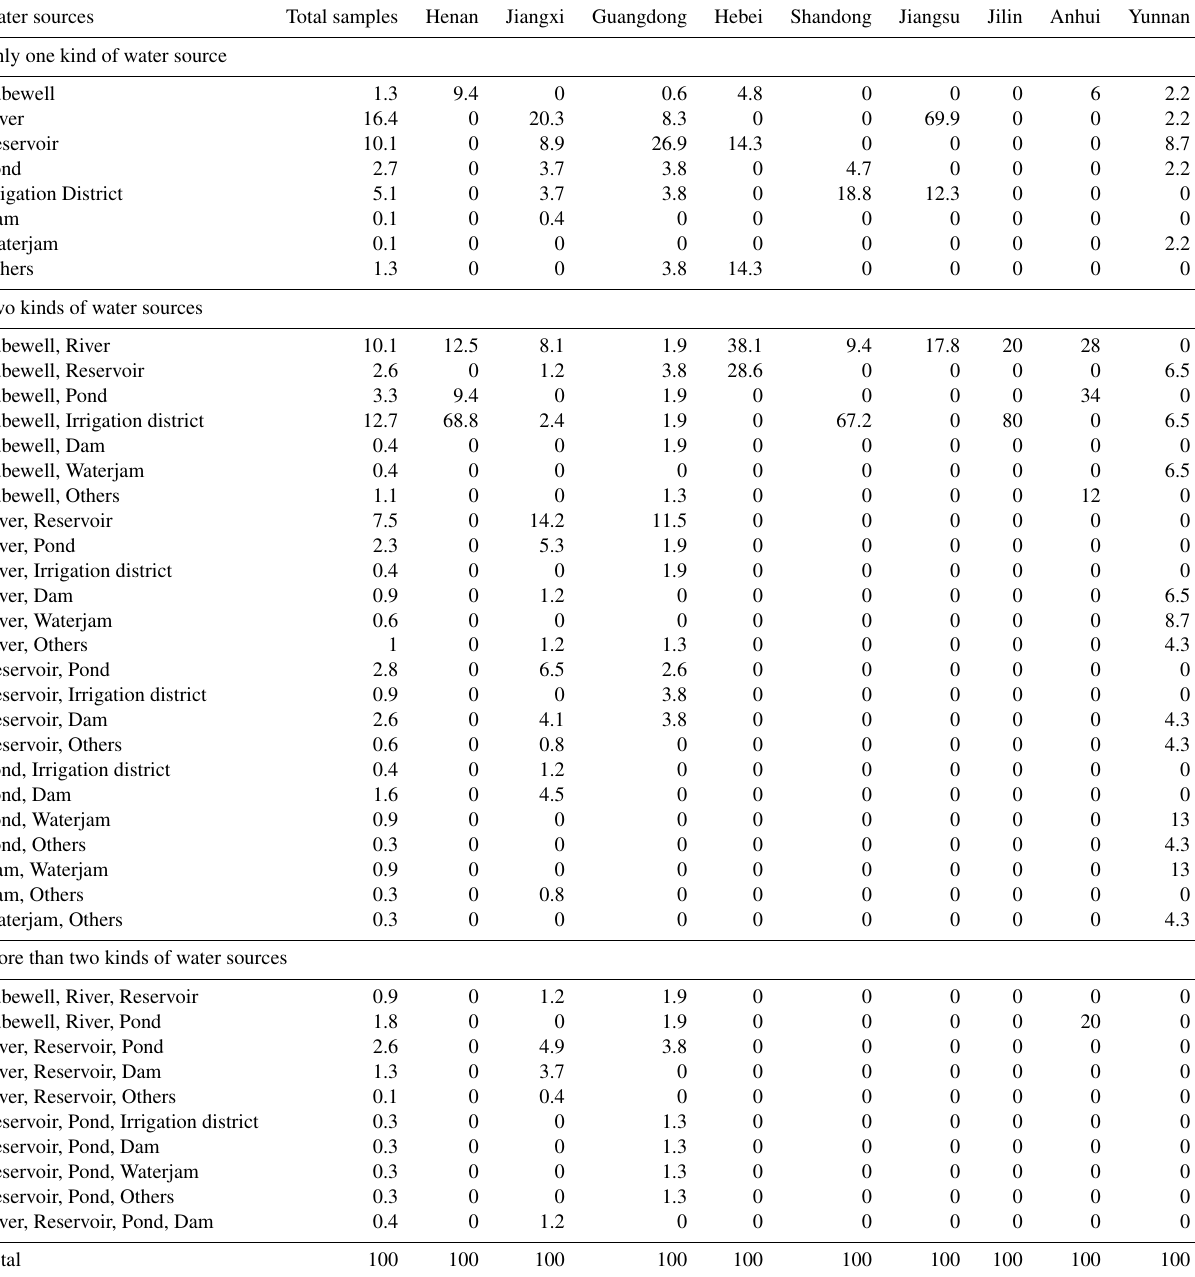
Table A4. Percentage of villages using kinds of water sources in sample regions (%). Water sources Total samples Henan Jiangxi Only one kind of water source Tubewell